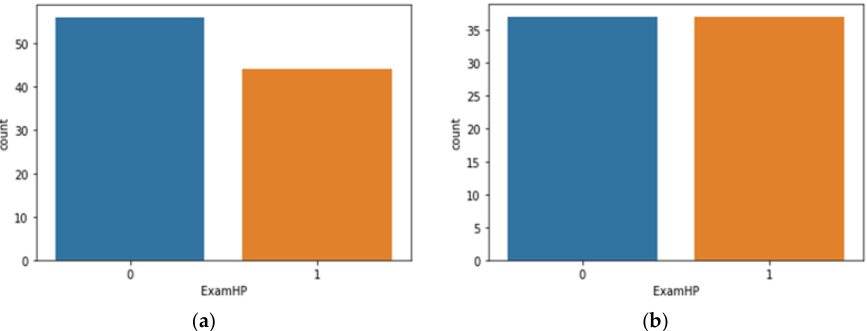
Figure 4. ( a ) imbalanced dataset, ( b ) SMOTE-based balanced dataset.